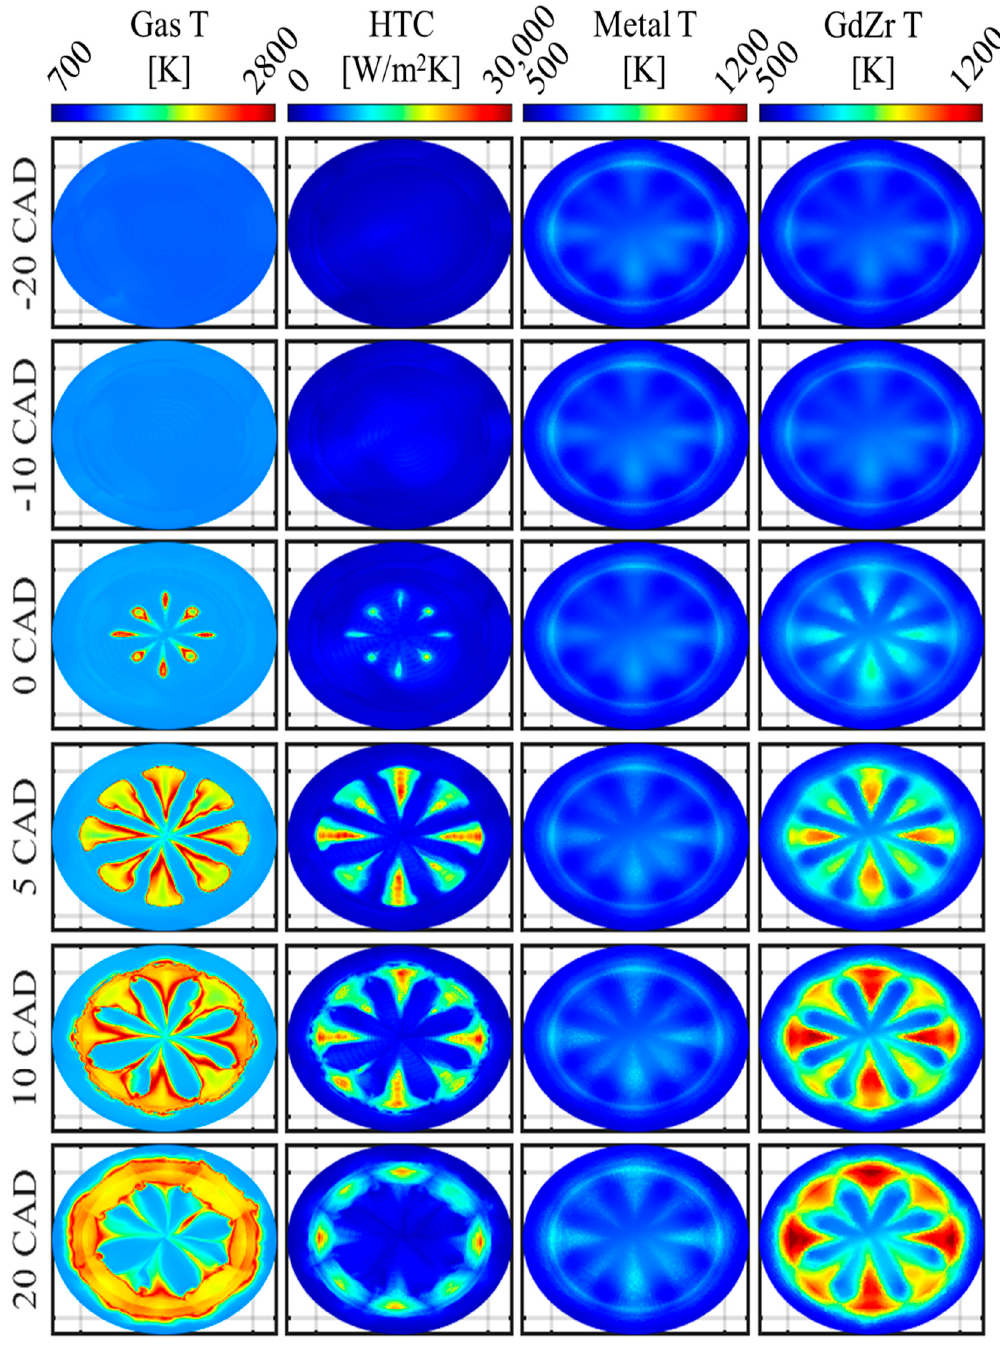
Figure 4. Boundary conditions and surface temperature profiles for full load 1000 rpm case. Column one represents the fluid cell temperature closest the piston surface, column two represents the heat transfer coefficient imposed at the wall nodes, column three shows the surface temperature of the metal piston, and column four shows the surface temperature of the 100-micron gadolinium zirconate coating.